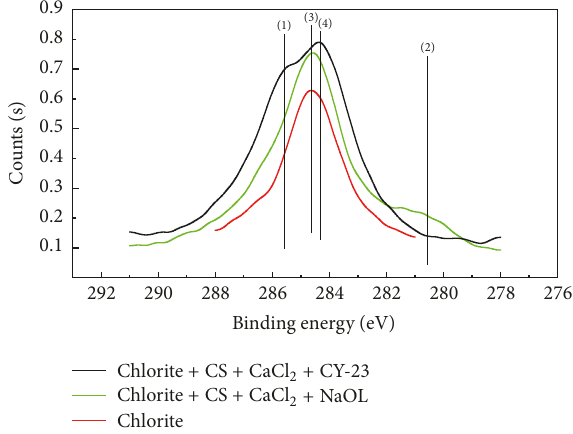
Figure 7: XPS extension atlas of surface carbon C1s before and after the reaction between chlorite and collector CY-23 or